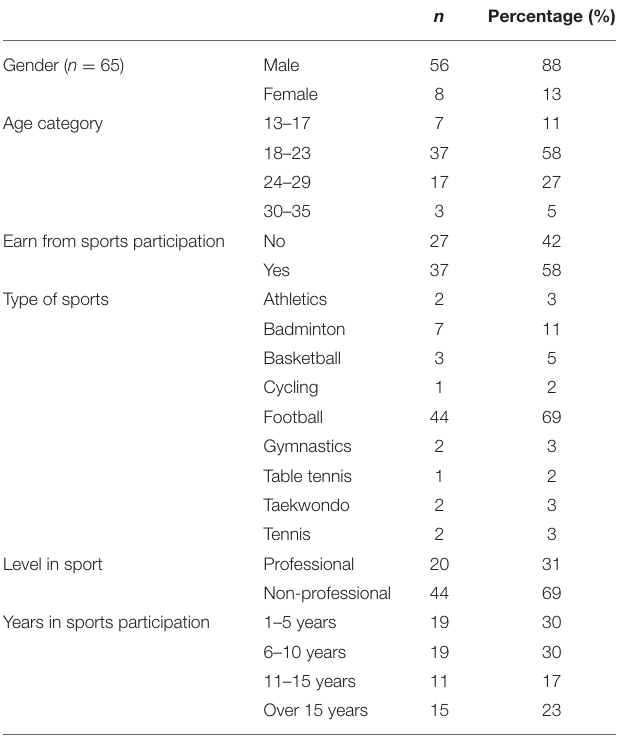
TABLE 3 | Mann-Whitney tests for psychological distress.